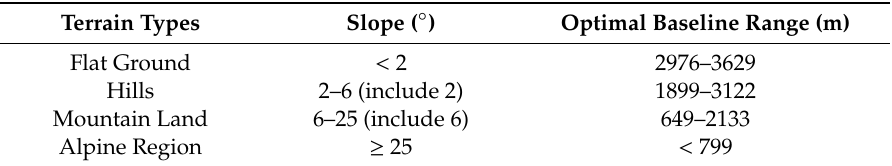
Table 3. Definition of the terrain types and optimal baseline range.